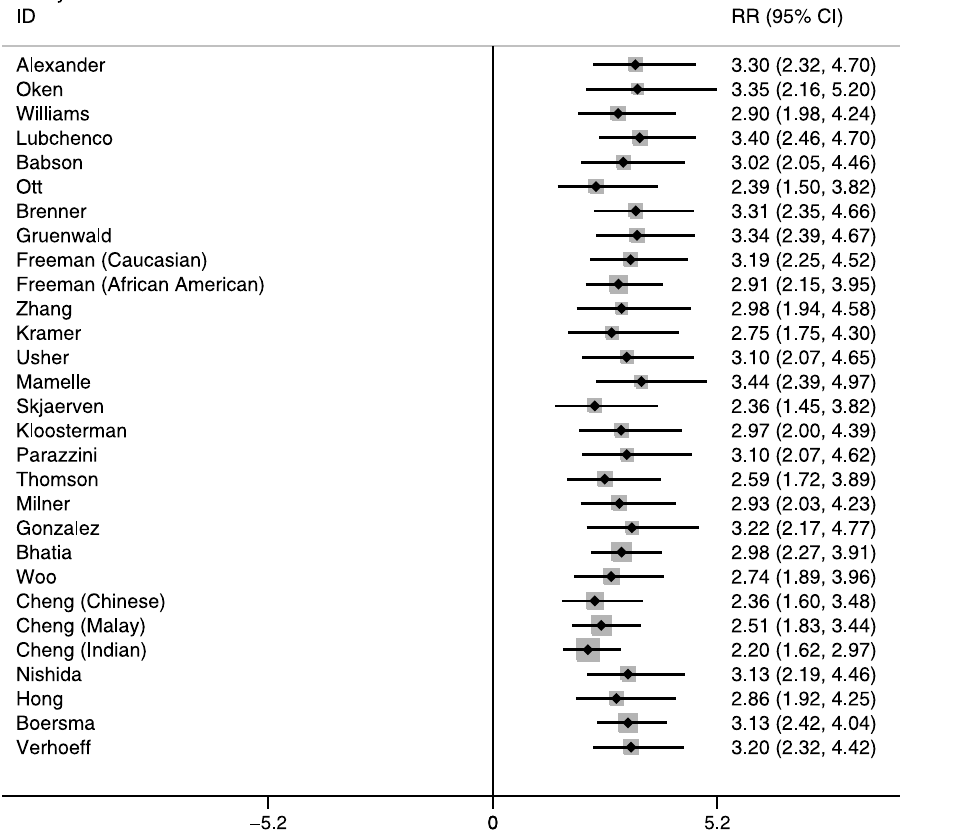
Figure 2. Risk ratios for Preterm-Appropriate-for-Gestational-Age, Neonatal Mortality: Southern Nepal (reference: Term- Appropriate-for-Gestational-Age).